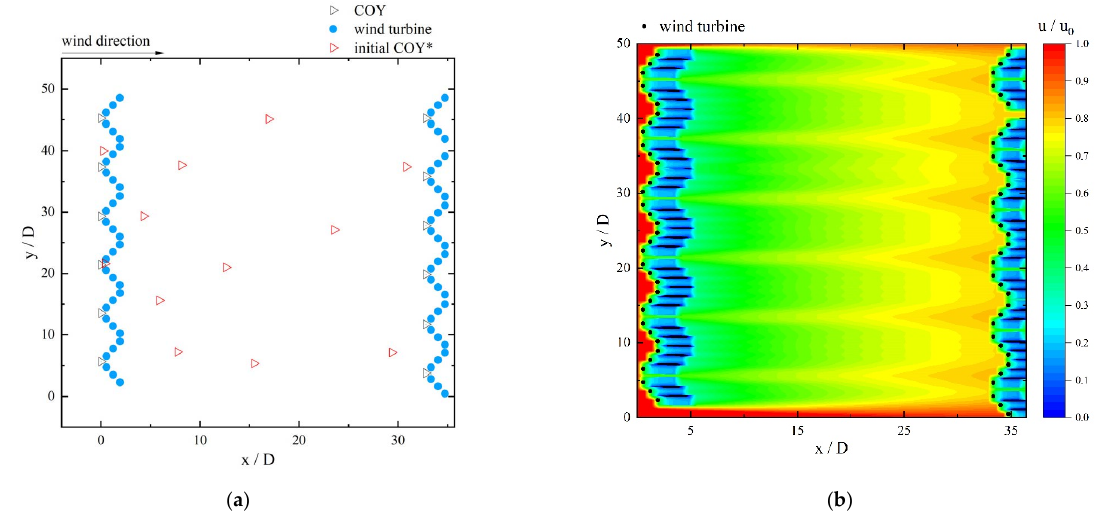
Figure 5. Optimized layout of 12 six-turbine platforms: ( a ) position of the platforms; ( b ) distribution of the velocity. * Not the initialization of the shown optimization, just to illustrate the way of random initialization.